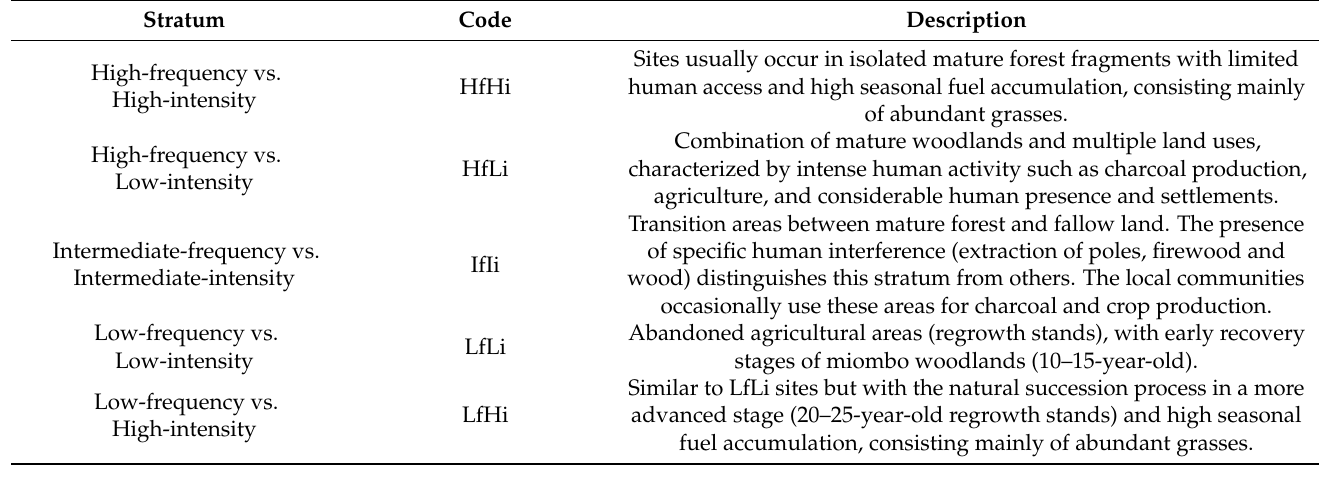
Table 1. General characteristics of each fire stratum for the miombo woodlands of the study area.